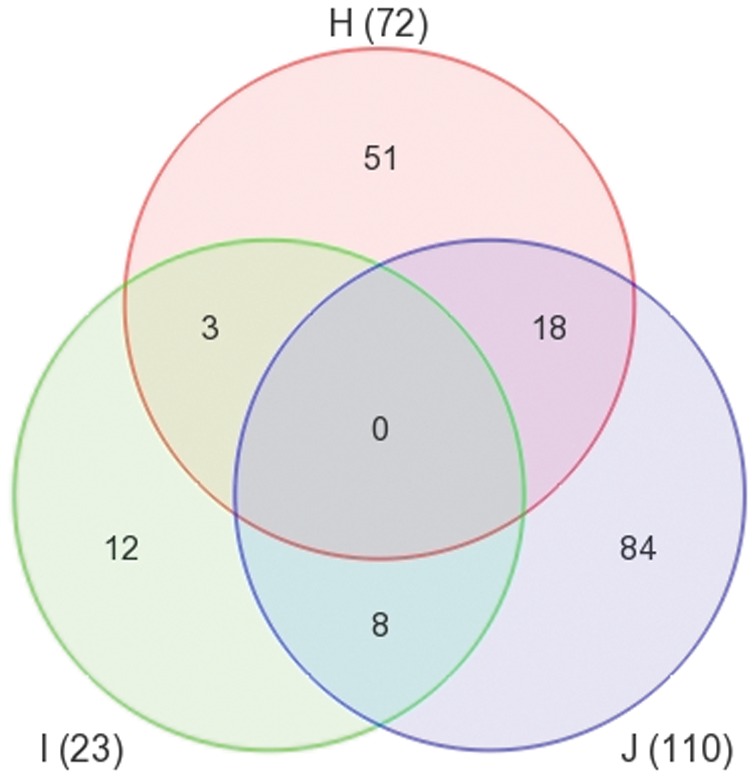
Venn diagram for differentially expressed transcript identifiers in paired comparisons.J: differentially expressed transcript identifiers identified in HCV-mono- versus HIV-mono-infected group; H: differentially expressed transcript identifiers identified in HCV/HIV-co-infected versus HCV-mono-infected group; I: differentially expressed transcript identifiers identified in HCV/HIV-co-infected versus HIV-mono-infected group.